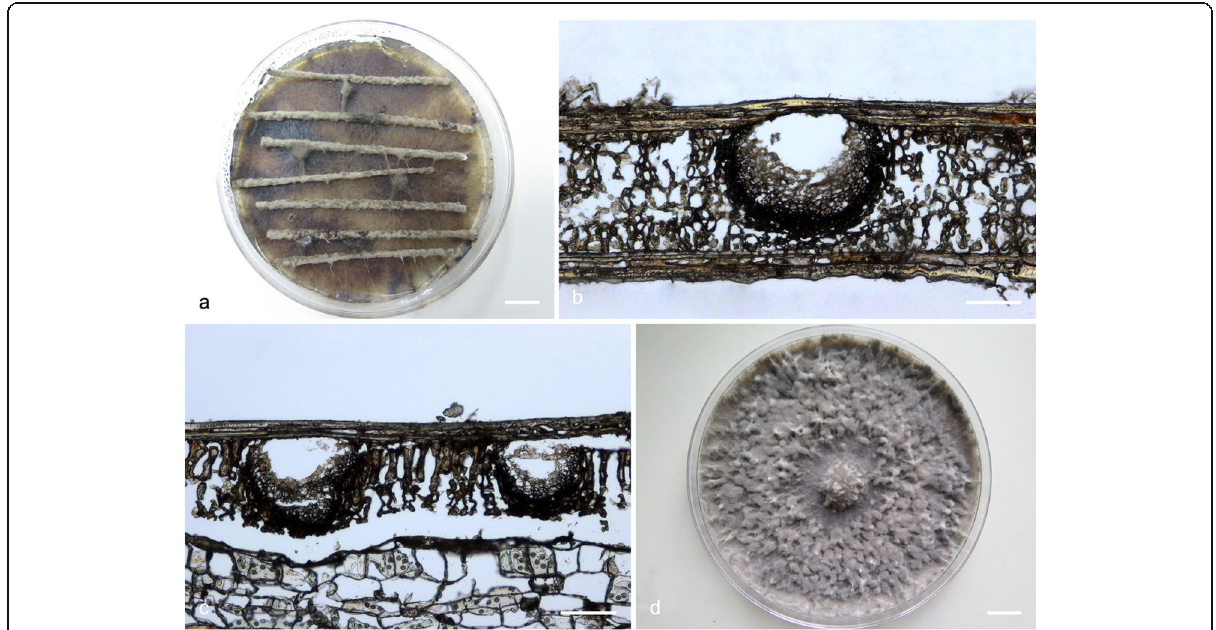
Fig. 8 Neofusicoccum ningerense. a . WA plate with pine needle to induce sporulation; b , c . Longitudinal section through conidiomata-like structure; d . Living culture after 10 d on 2% MEA (front). Scale bars: a, d = 1 cm; b, c = 100 μ